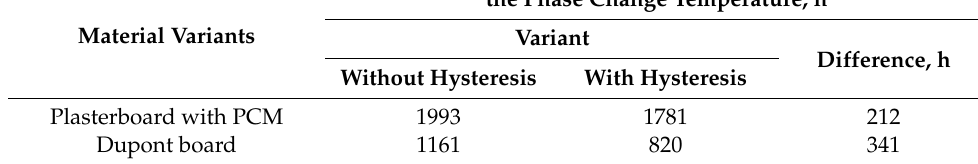
Table 2. Frequency of occurrence of the surface temperature of PCM below the phase change temperature in individual material variants and calculation